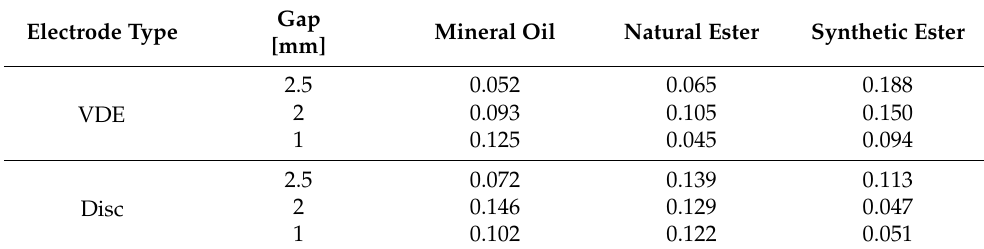
Table 4. Standard deviation/BDV ( s / x ) for AC BDV test